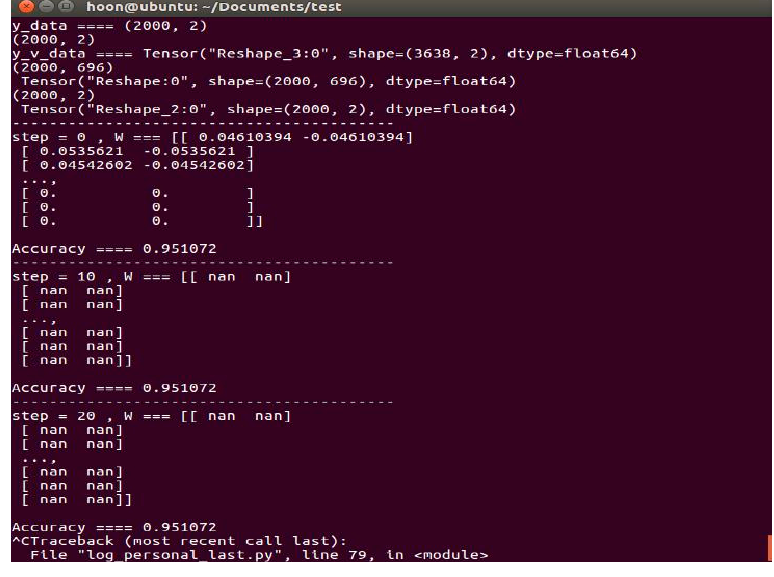
Figure 9. Data overshooting.